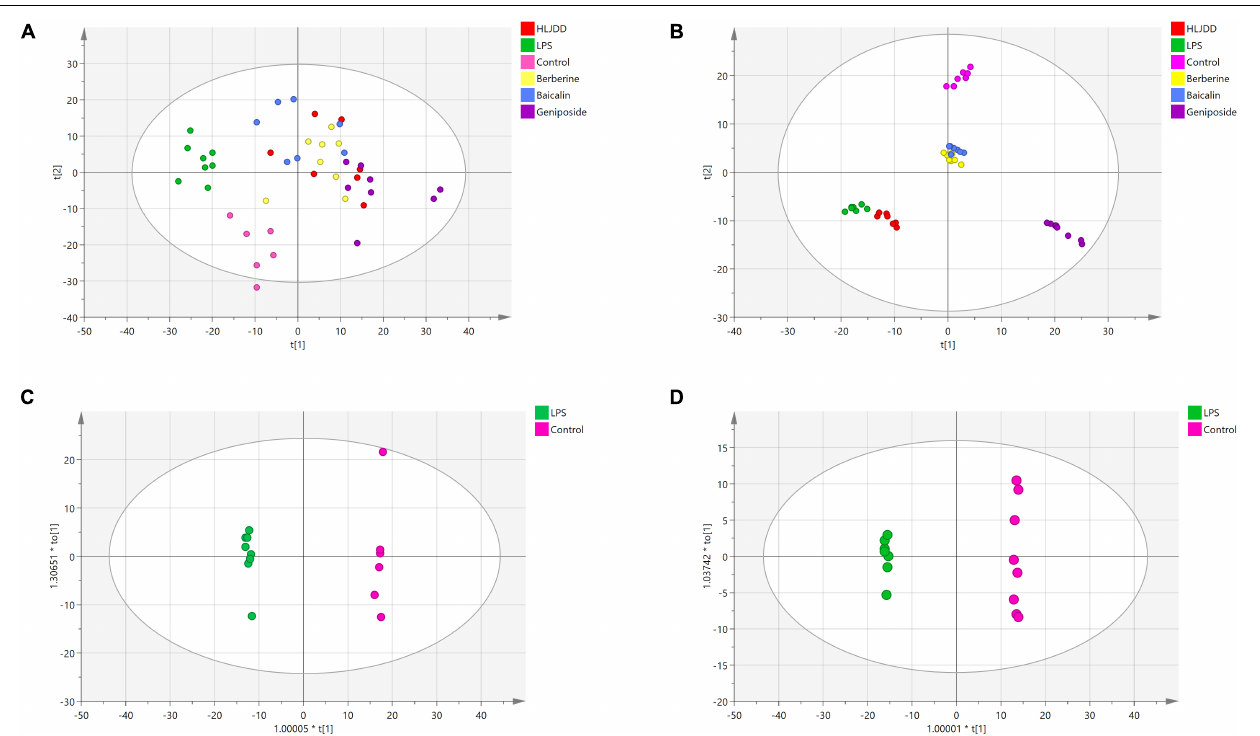
FIGURE 4 | Principal component analysis (PCA) scores of zebrafish samples in six groups and orthogonal projection to latent structures discriminant analysis (OPLS-DA) scores in the control group and lipopolysaccharide (LPS) group. (A) PCA analysis in ESI + mode. (B) PCA analysis in ESI − mode. (C) OPLS-DA analysis in ESI + mode. (D) OPLS-DA analysis in ESI − mode. Red, green, pink, yellow, blue, and purple symbols represent samples of the HLJDD, LPS, control, berberine, baicalin, and geniposide groups,